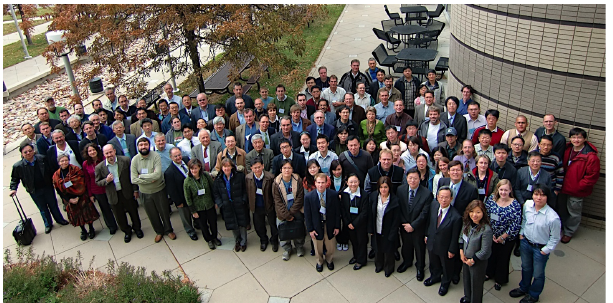
Fig. 43. Participants in fourth COSMIC Users’ Workshop, October 2009, Boulder, Colorado (http://www.cosmic.ucar.edu/ oct2009workshop/index.html ) (Photo by Caryle Calvin,